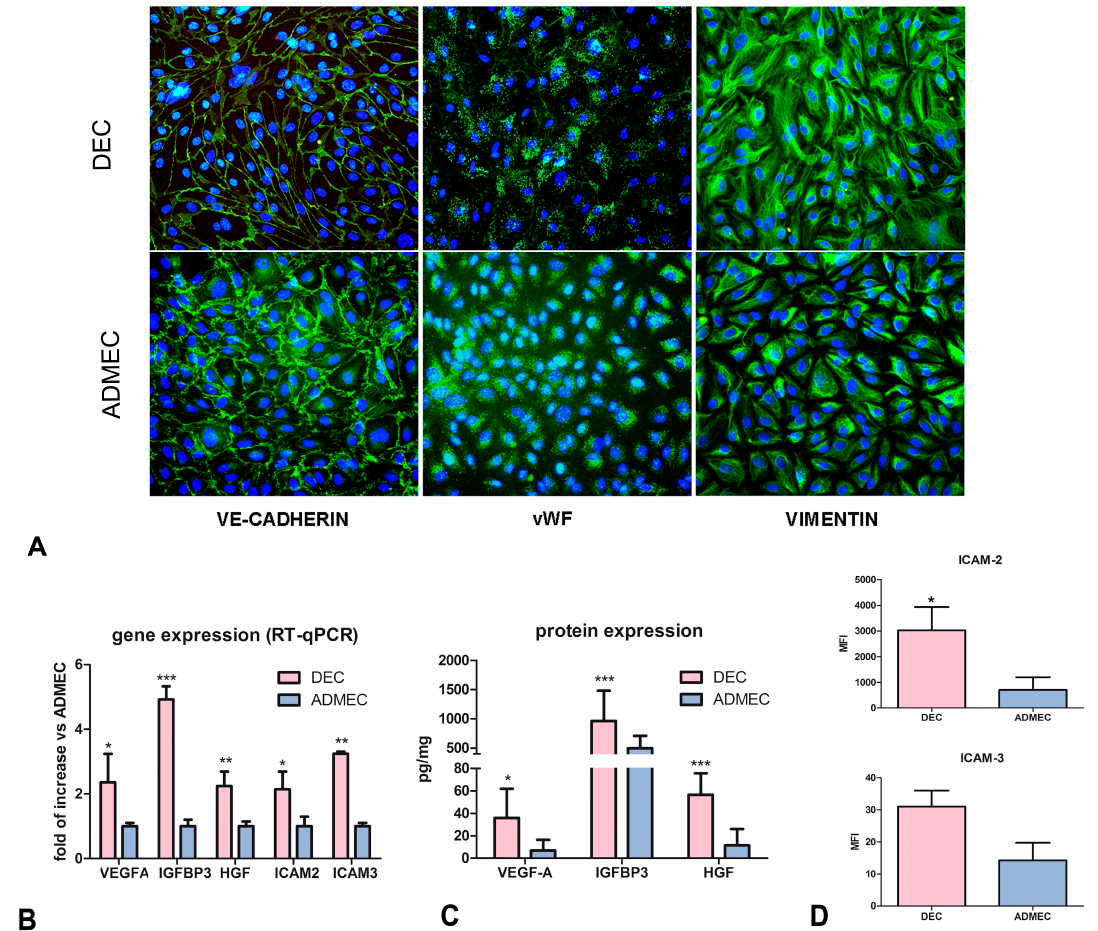
Figure 1. Phenotypic characterization of DECs and ADMECs. ( A ) Immunofluorescence analysis of vWF, VE-cadherin and vimentin on isolated and cultured DECs and ADMECs. Original magnification: 200 × . ( B ) RT-qPCR of VEGF-A, HGF, IGFBP3, ICAM-2 and ICAM-3 genes differentially expressed by DECs and ADMECs. The data represent the mean ± SD of triplicate samples from five separate experiments, * p < 0.05, ** p < 0.01, *** p < 0.005. ( C ) Evaluation of the production of VEGF-A, HGF and IGFBP3 proteins in the supernatants of a confluent monolayer of DECs and ADMECs after 4 h of culture using a commercial ELISA kit. The data represent the mean ± SD of triplicate samples from five separate experiments. * p < 0.05, ** p < 0.01, *** p < 0.005. ( D ) Cytofluorimetric analysis for the expression of ICAM-2 and ICAM-3 in basal condition of freshly isolated DECs and ADMECs. The ECs were incubated with PE-conjugated mouse anti-human ICAM-2 and ICAM-3 mAb. PE-conjugated isotype-matched IgG2a or IgG1 were used as negative control, respectively. Data are represented as mean ± SD of the Mean Fluorescence Intensity (MFI) of five separate experiments.